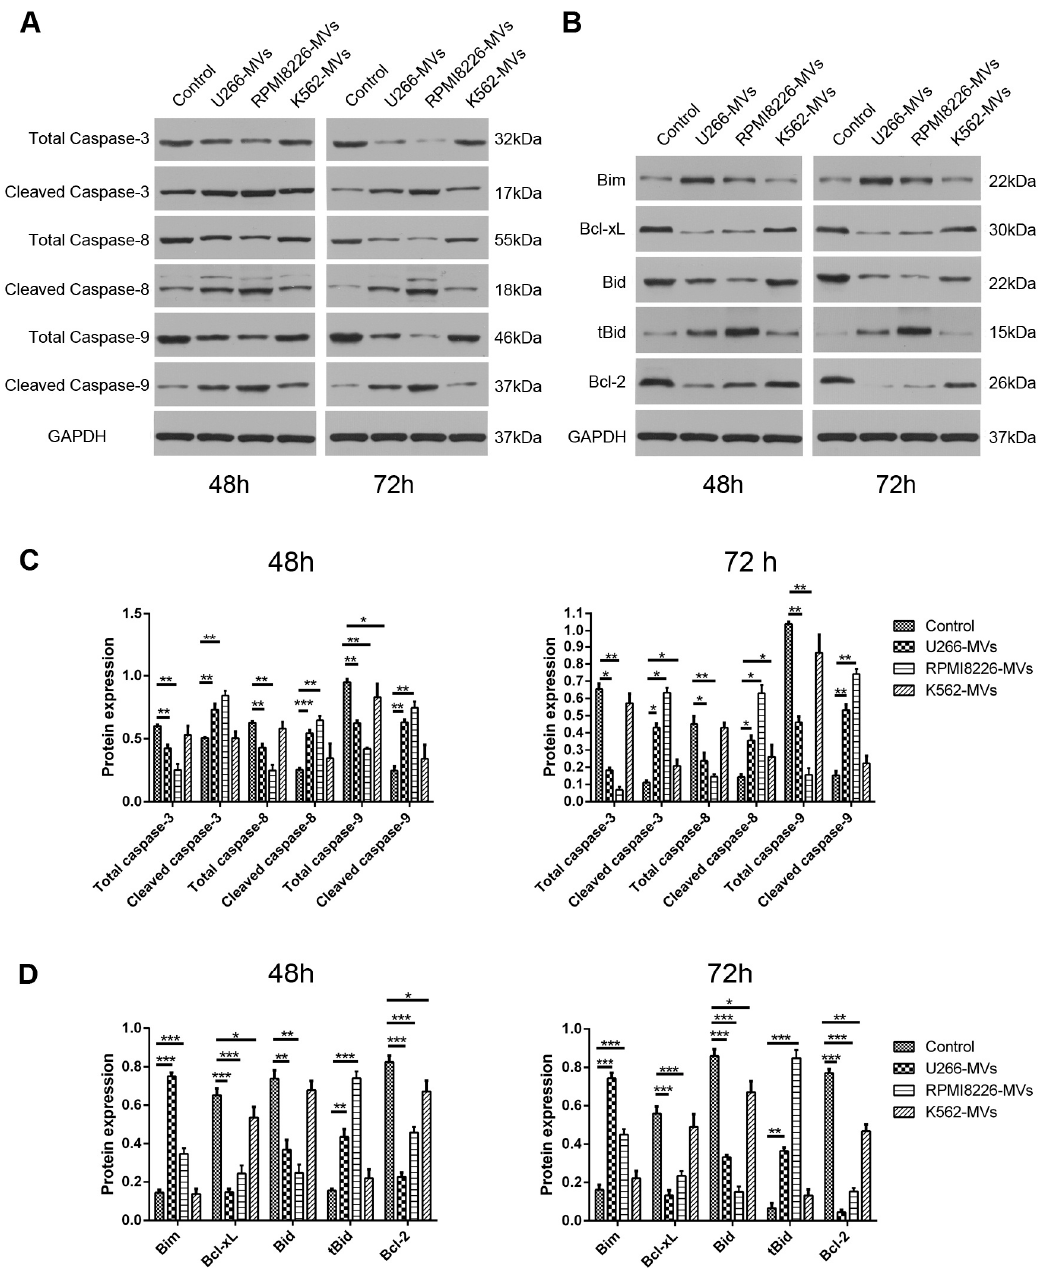
Figure 3. Activated apoptotic pathways of caspase-3, -8, and -9 and Bcl-2 family members in HK-2 cells treated with MM-MVs. HK-2 cells were treated with MM-MVs and K562-MVs (10 µ g/mL) and the expression of proteins was assayed by Western blotting. ( A , C ) MM-MVs, but not K562-MVs, significantly induced the activation of caspase-3, -8, and -9. Both U266-MVs and RPMI8226-MVs reduced the expression of total caspase-3, -8, and -9, and increased the expression of cleaved caspase-3, -8, and -9; ( B , D ) MM-MVs up-regulated pro-apoptotic Bim and tBid proteins and down-regulated anti-apoptotic Bcl-xL and Bcl-2 proteins. Bar graphs for ( A , B ) were shown in ( C , D ), respectively. Each value was expressed as mean ± SD of three independent experiments. * p < 0.05, ** p < 0.01, *** p < 0.001 vs. control. 2.4. MM-MVs up-regulate E-cadherin protein and down-regulate vimentin protein in HK-2 cells.